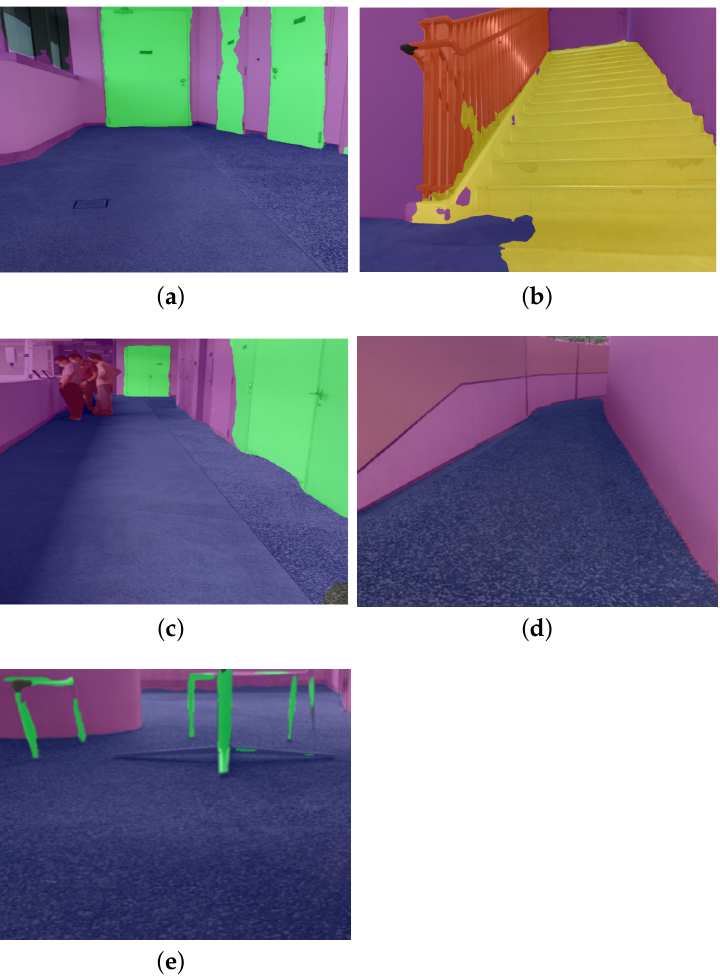
Figure 12. The online test results of the locomotion mode recognition framework. ( a ) Floor, static object, and wall. ( b ) Railing, stairs, floor and wall. ( c ) Floor, person, static object, and wall. ( d ) Floor and wall. ( e ) Floor, static object, and